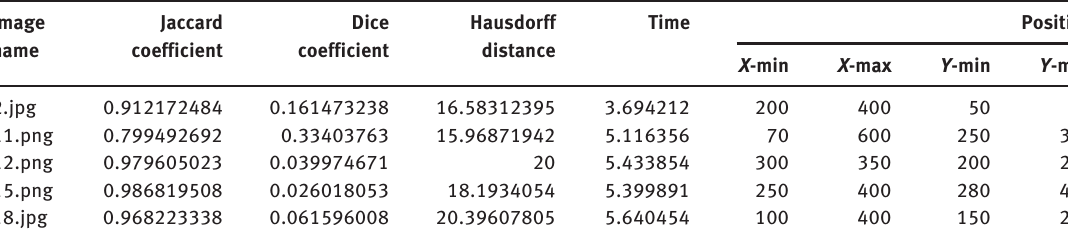
Table 3: Performance Analysis without the Optimization Technique. Image